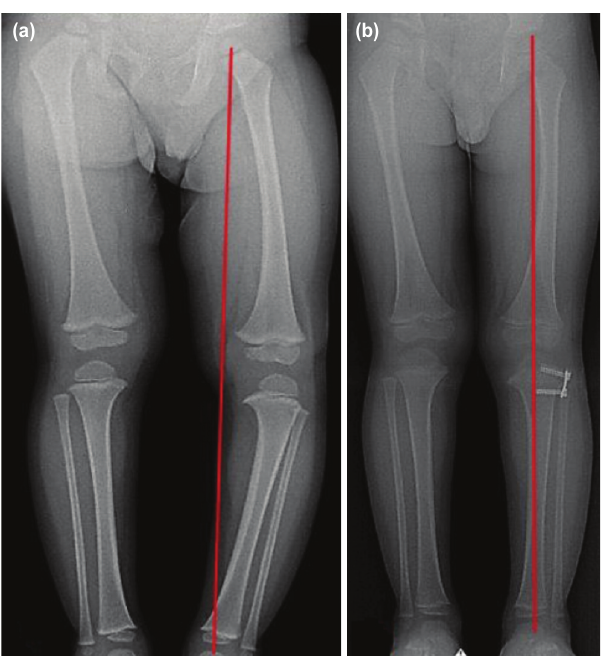
The three zones of the knee on the anteroposterior Fig. 1: radiograph. Mechanical axis drawn from the centre of the femoral head to the centre of the ankle joint should pass through the central part of the knee joint (zone 1). Zones 2 and 3 lie outside the mechanical axis.